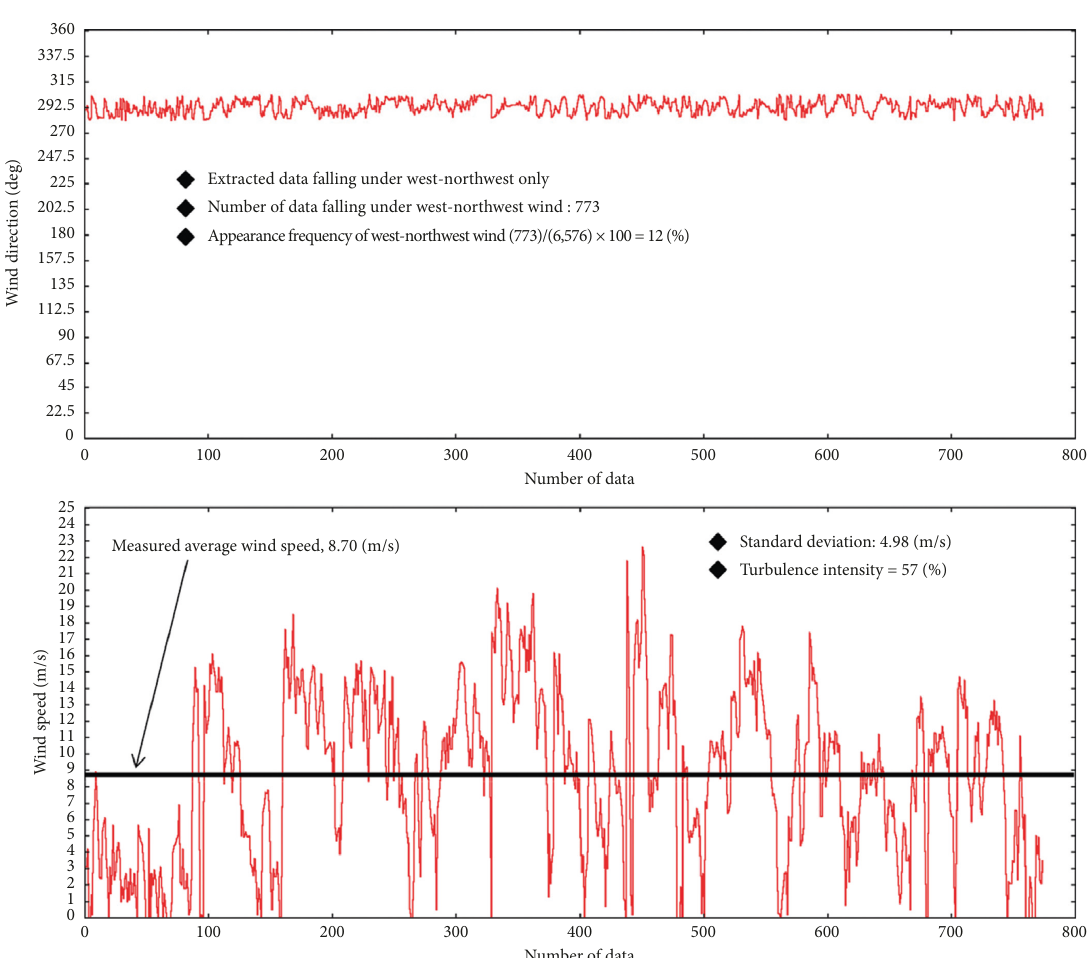
Figure 6: West-northwest wind speed data (defined angles clockwise between 281.25 degrees or more and less than 303.75 degrees), consecutively arranged in time direction.